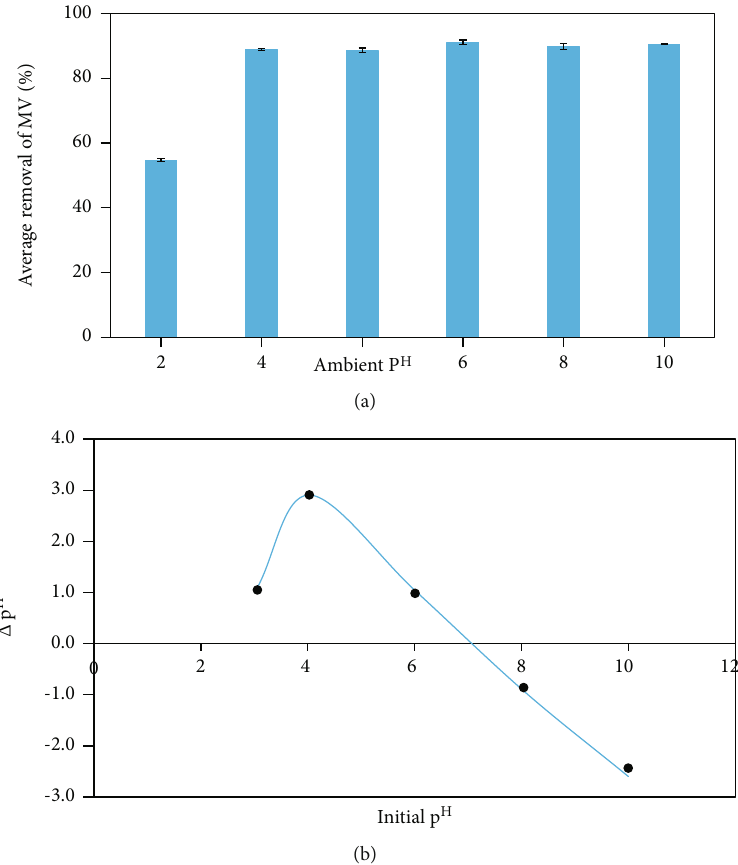
Figure 5: (a) The e ff ect of pH on adsorption of MV and (b) Determination of pH MV solution = 10 : 0 mL; concentration of MV = 100 mgL -1